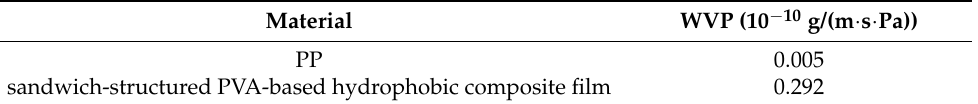
Table 5. WVP of the sandwich-structured PVA-based hydrophobic composite film and a commercially available PP straw.